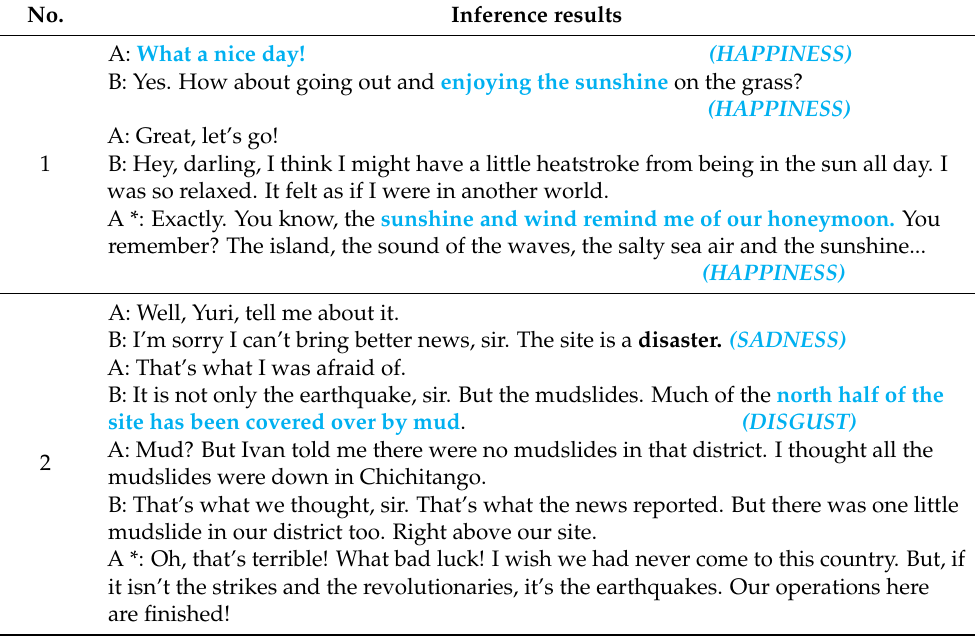
Table 5. Inference results of our proposed